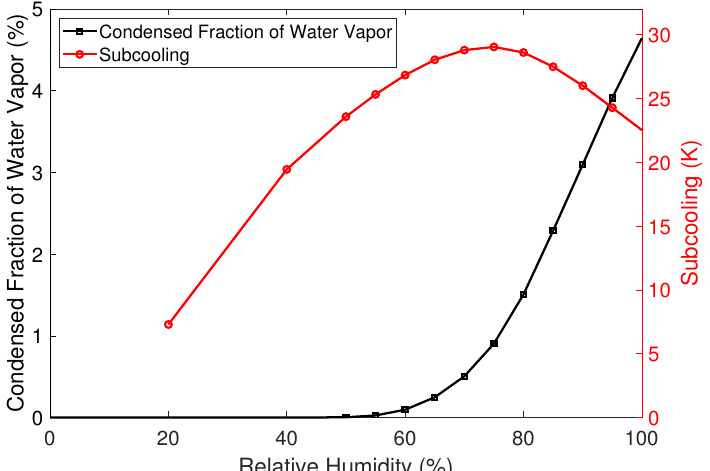
Figure 5. Condensed fraction of water vapor and subcooling after the turbine. Data taken from [12].